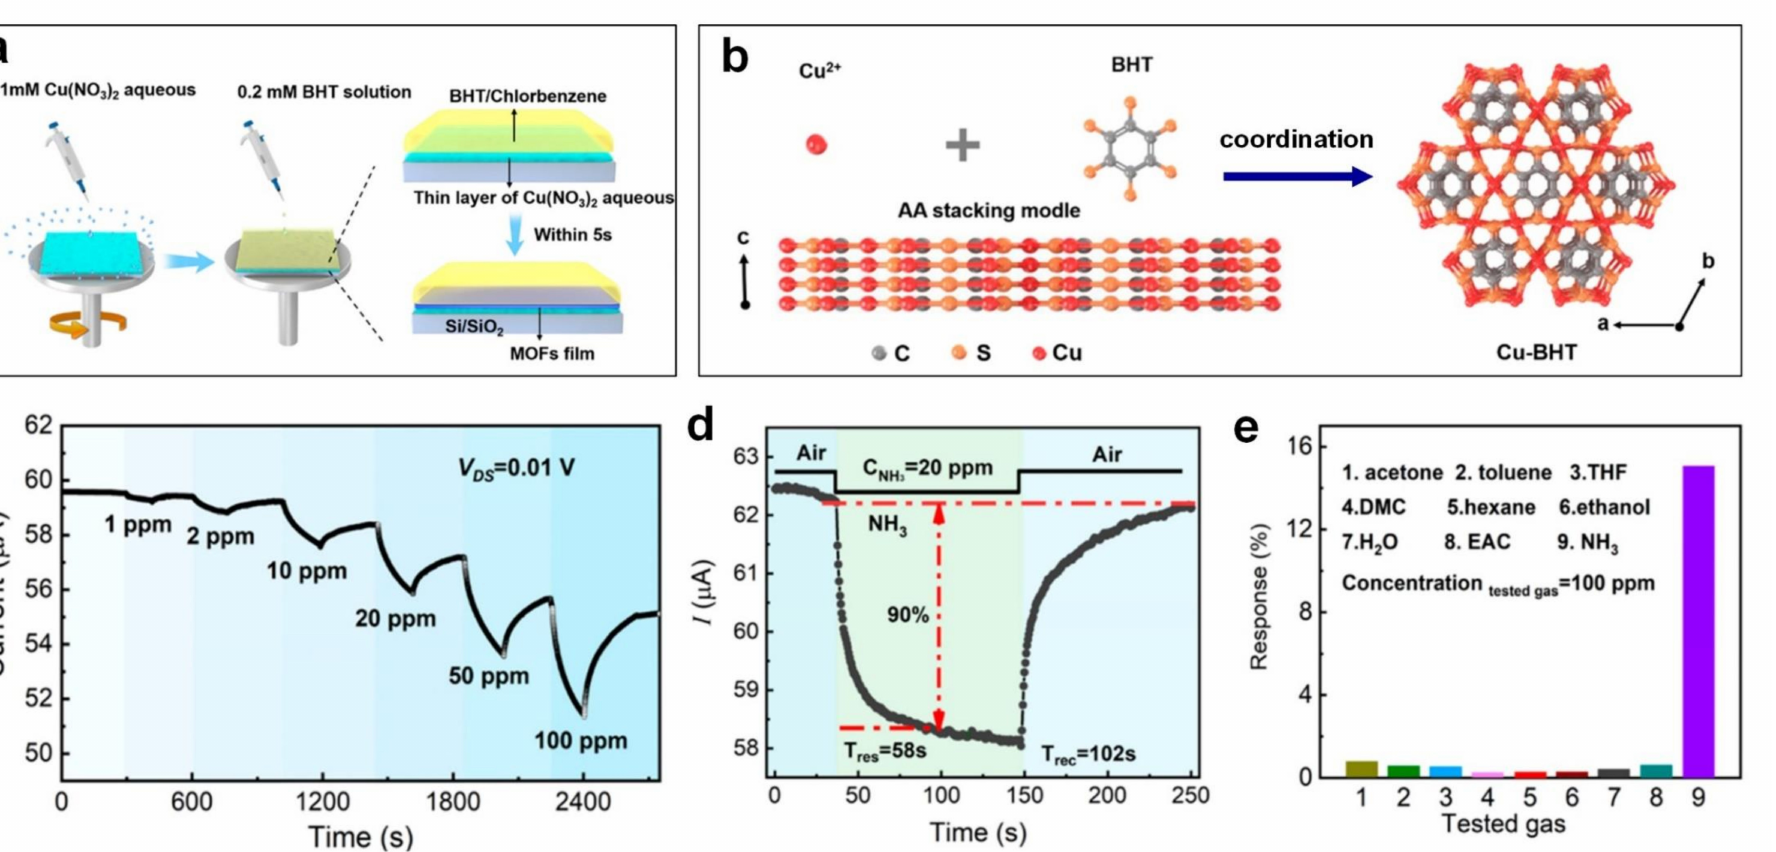
Figure 10. ( a ) Schematic illustrations of ultrafast in situ synthesis of large-area Cu-BHT on Si/SiO 2 substrate. ( b ) Demonstrations of Cu-BHT crystalline structure and AA stacking model. ( c ) The dynamic current variations under different NH 3 concentrations. ( d ) Response kinetics of Cu-BHT film towards 20 ppm NH 3 . ( e ) Cross-selectivity of Cu-BHT film towards various reducing gases with the concentration of 100 ppm. Reproduced with permission from [108] American Chemical Society,